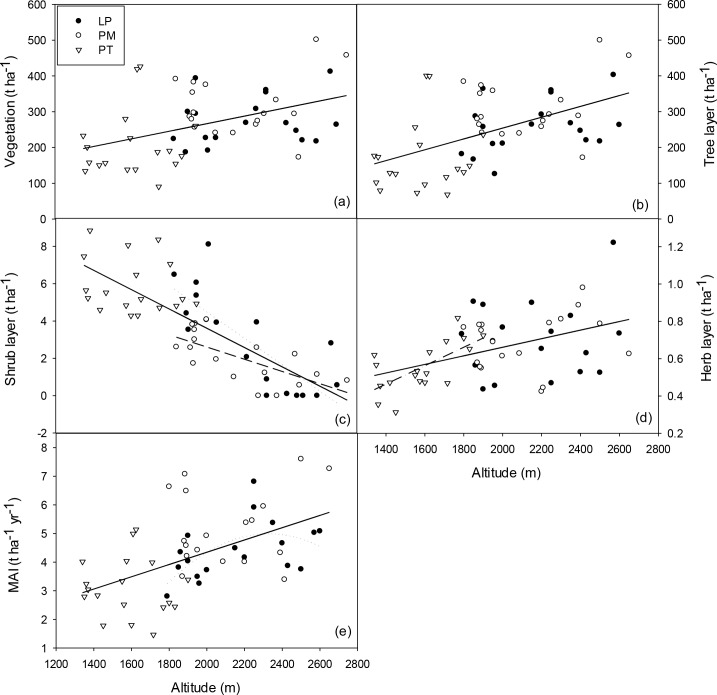
Vegetation (a), tree layer (b), shrub layer (c) and herb layer biomass (d) and MAI (e) along the altitudinal gradient in three coniferous forests on the Loess Plateau, China. MAI, mean annual increment; LP, Larix principis-rupprechtii forest; PM, Picea meyerii forest; PT, Pinus tabulaeformis forest. Shrub and herb layer biomass were presented after square-root transformation. Solid lines represent significant linear relationships between altitude and vegetation biomass (r2 = 0.19, p<0.001), tree layer biomass (r2 = 0.27, p<0.001), shrub layer biomass (r2 = 0.62, p<0.001) and herb layer biomass (r2 = 0.22, p<0.001) and MAI (r2 = 0.29, p<0.001) respectively across the three forests. Dotted lines represent a significant linear relationship between altitude and shrub layer biomass (r2 = 0.62, p<0.001) and a significant quadric relationship between altitude and MAI (r2 = 0.32, p = 0.057) respectively in LP forest. Long dash line represents a significant linear relationship between altitude and shrub layer biomass (r2 = 0.47, p = 0.002) in PM forest. Dot-dash line represents the significant linear relationship between altitude and herb layer biomass (r2 = 0.43, p = 0.003) in PT forest.